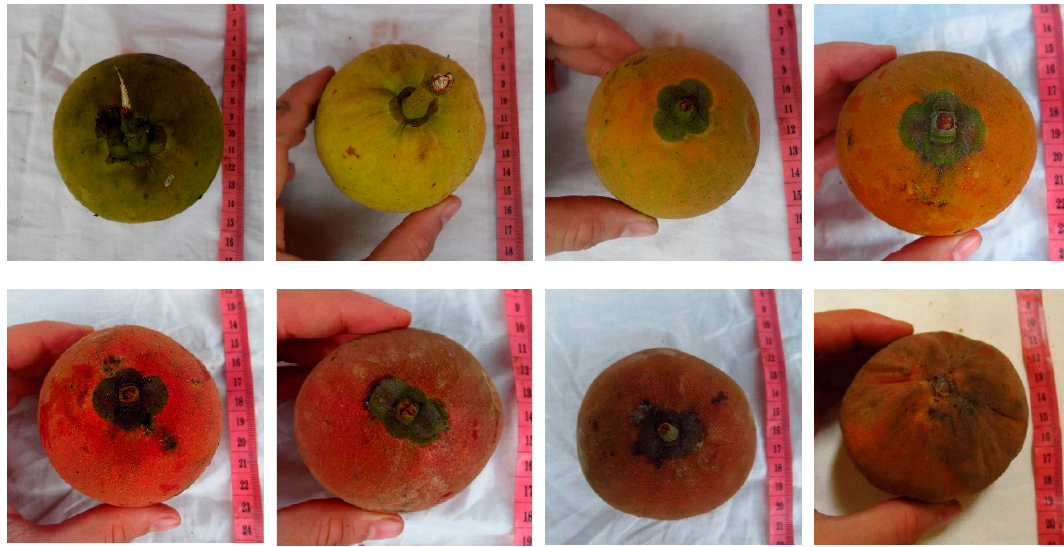
Figure 4. Ripening stages of G. kola fruits, from immature (green) to overripe (brownish). Source: author’s archive.